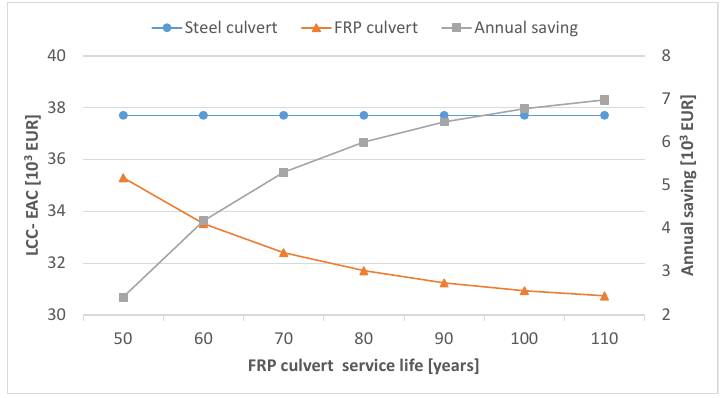
Figure 17. Impact of the FRP culvert bridge’s life span on the total LCC and annual saving.